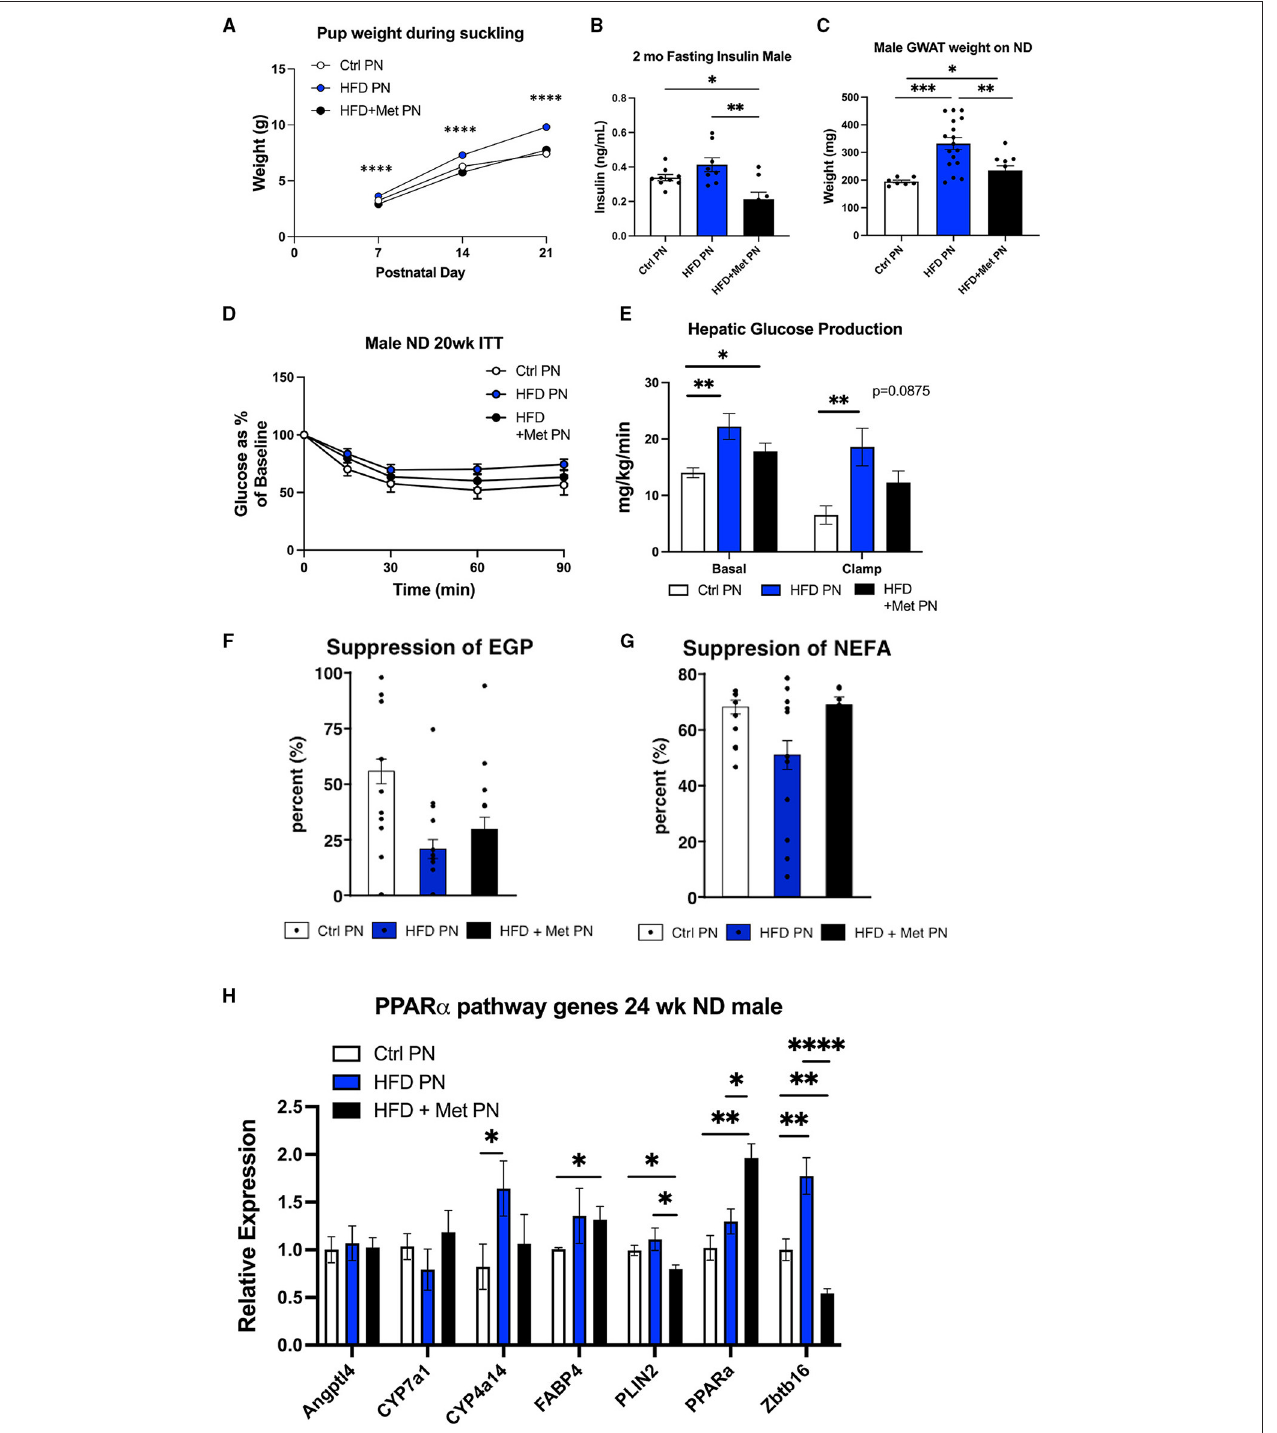
FIGURE 6 | Impact of metformin given during lactation at the time of HFD exposure on offspring. White values are for Ctrl PN, blue are for HFD PN, and black are for HFD + Met PN offspring (A) . Pup weights during lactation averaged by litter ( n = 6–7 litters) (B) . Fasting insulin in male offspring at 2 months of age (C) . Visceral fat pad weight (GWAT) in male offspring at necropsy at 6 months (D) . Insulin tolerance test at 5 months ( n = 7–8) (E) . Hepatic glucose production at basal and clamped conditions during the hyperinsulin mice uglycemic clamp (HEC). This is the same clamp as in Figure 3 in which Ctrl PN and HFD PN results were shown, repeated here with the addition of the HFD + Met PN group ( n = 8–11) (F) . Percent suppression of endogenous glucose production (G) . Percent suppression of lipolysis on clamp (H) . PPAR-alpha pathway genes in adult male offspring-fed ND at 6 months ( n = 5–8). Ctrl PN and HFDPN expression results were previously shown in Figure 5D , repeated here with the addition of the HFD + Met PN group. Ctrl, control; HFD, high-fat diet; PN, post-natal; Met, metformin. * p < 0.05, ** p < 0.01, *** p < 0.001, **** p < 0.0001.